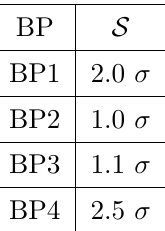
Table 6 . Signal signi(cid:12)cance for the benchmark points at 14 TeV with L = 3000 fb (cid:0) 1 for case II. comparatively low heavy Higgs masses. Moreover, this benchmark also has all relevant branching fractions, namely, those for H ! (cid:31)(cid:31); H (cid:6) ! HW (cid:6) and H (cid:6)(cid:6) ! W (cid:6) W (cid:6) , working in favour of the signal. It has Br( H ! (cid:31)(cid:31) (cid:25) 90%). On the other hand, BP1 has the lowest triplet VEV among the three BPs. In this case H (cid:6) decays mostly to HW (cid:6) (cid:12)nal state. BP4, which has slightly smaller signal cross-section compared to BP1, still yields a higher signal signi(cid:12)cance, because of the larger e(cid:14)ciency of the =E cut as can be seen T in table 5. For BP2, however, other decay channels like hW (cid:6) ; t (cid:22) b etc open up, hence the Br( H (cid:6) ! HW (cid:6) ) falls (27% in case of BP2 as this channel has the largest VEV).